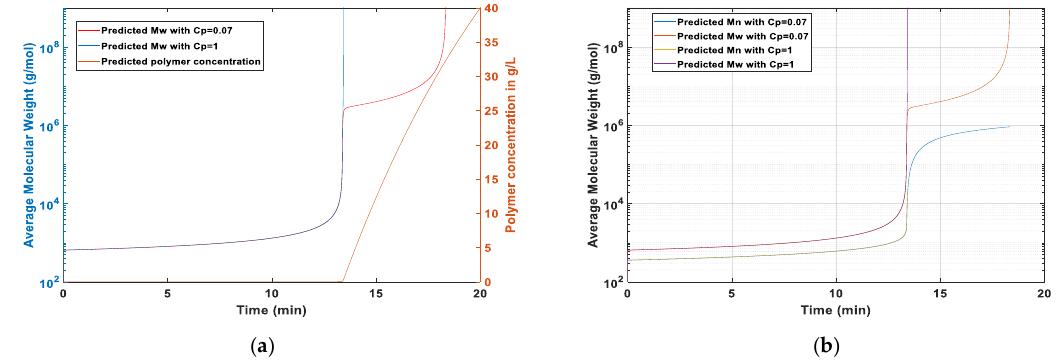
Figure 7. Predicted time-evolution of polymer concentration and average molecular weights up to gelation for a typical run performed in this work concerning AAm/MBAm polymerization with APS/TEMED initiation ( 𝑇 = 26 °C,𝑌 𝑀 = 9%, 𝑌 𝐶𝐿 = 0.5%, and 𝑌 𝐼 = 0.1%). ( a ) Polymer concentration (g/L) and 𝑀̅ 𝑤 considering two different values for the reactivity of the pendant double bonds ( 𝐶 𝑝 ). ( b ) 𝑀̅ 𝑛 and 𝑀̅ 𝑤 up to gelation considering two values for 𝐶 𝑝 .